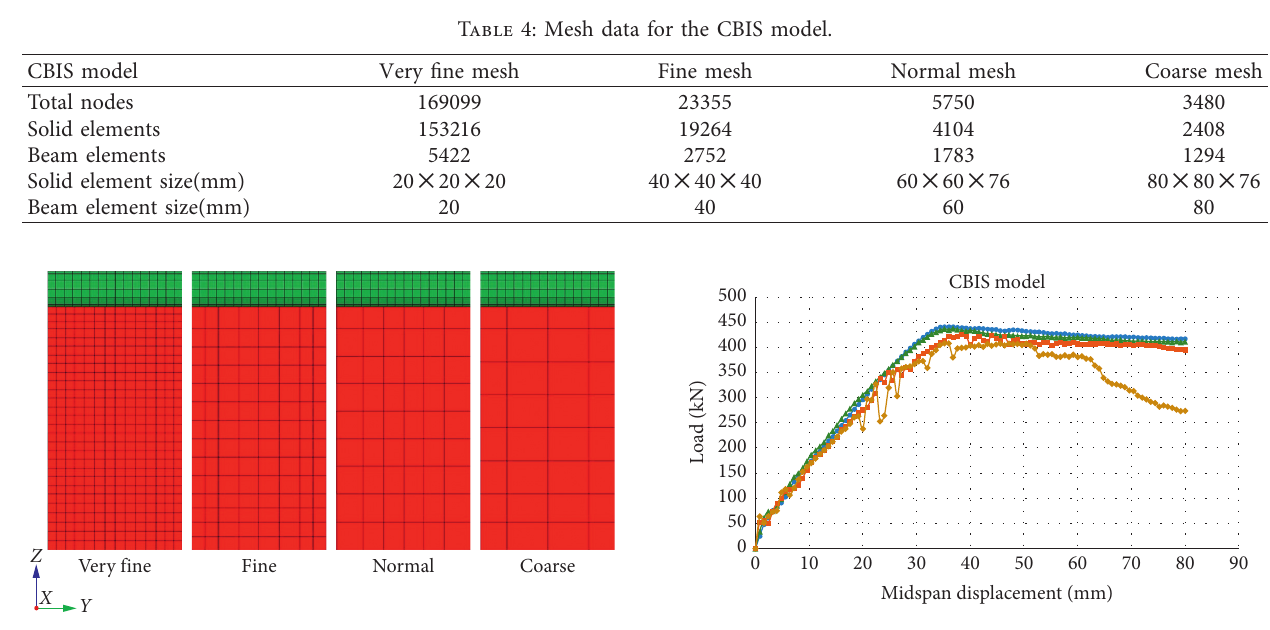
Figure 6: Mesh design for the discrete model.